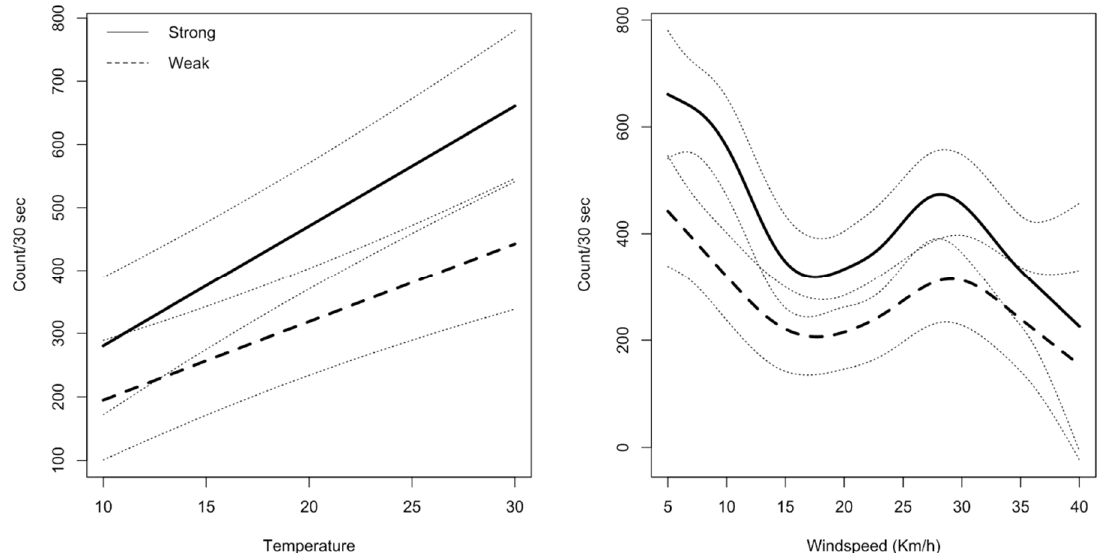
Figure 3. Estimated mean honey bee counts per 30 s with 95% confidence intervals, based on counts at 1400 h analyzed against temperature (°C) and windspeed (Kmph) for strong hives (solid line) versus weak hives (dotted line) in autumn.